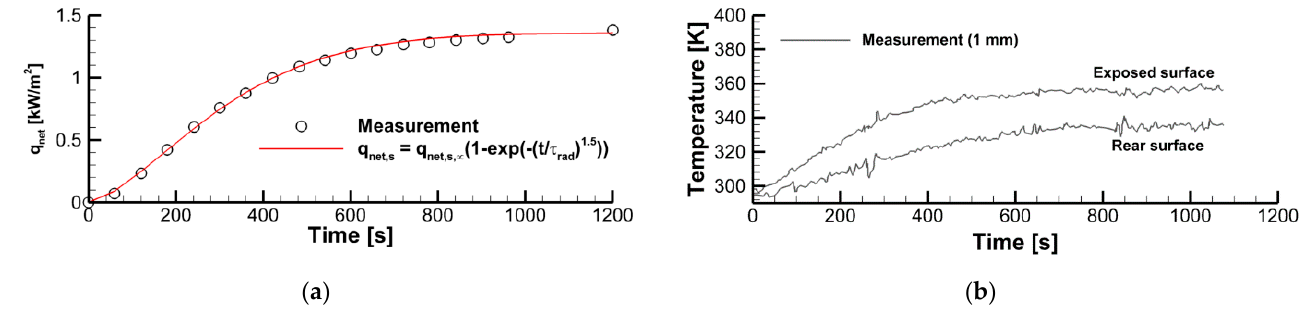
Figure 3. Transient variation of the net heat flux received by the sensor ( a ) and the thermocouple output ( b ).